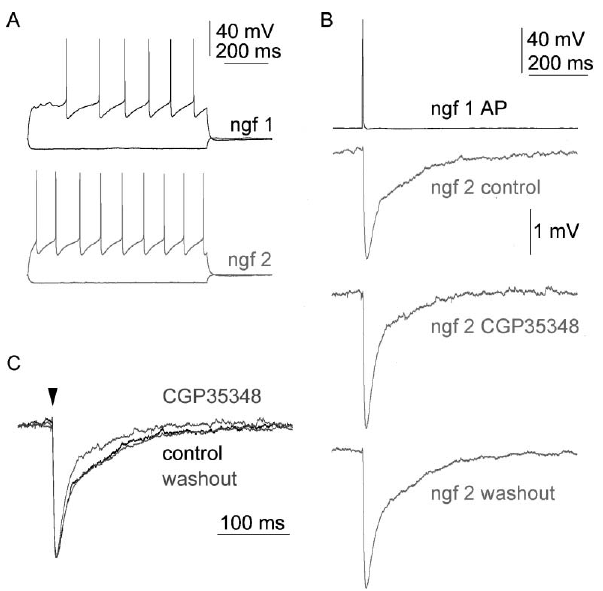
Figure 3. GABAB receptors contribute to IPSPs between neurogliaform cellsintheratcortex .( A )Firingpatternsoftwoneurogliaformcells(ngf1and ngf 2). ( B ) Single action potentials in the presynaptic neurogliaform cell elicited slow IPSPs in the postsynaptic neurogliaform cell. The decay of the IPSP could be shortened by the applicaion of the GABAB receptor blocker CGP35348 (60 µ M). The late component of IPSP showed recovery after 30minute of washout. ( C ) Superimposed traces are shown normalized to the control IPSP.